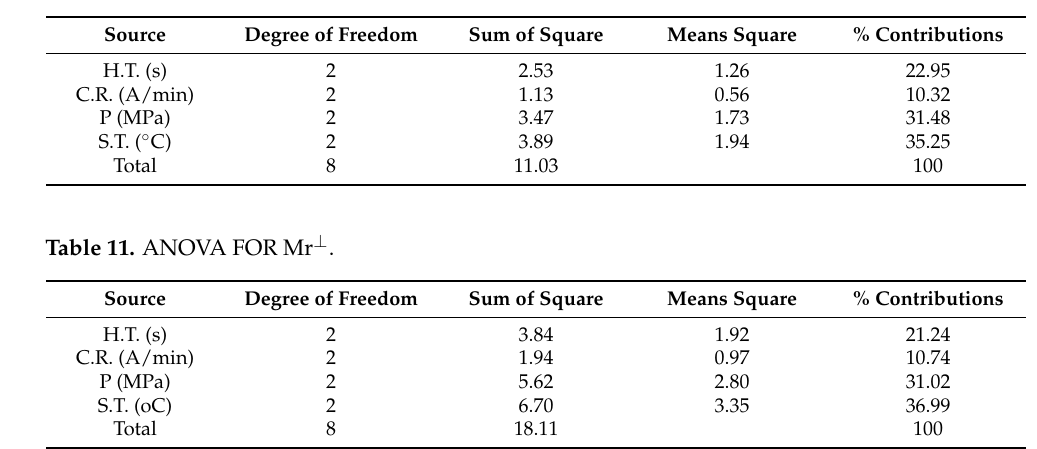
Table 10. ANOVA for Mr (cid:107) .